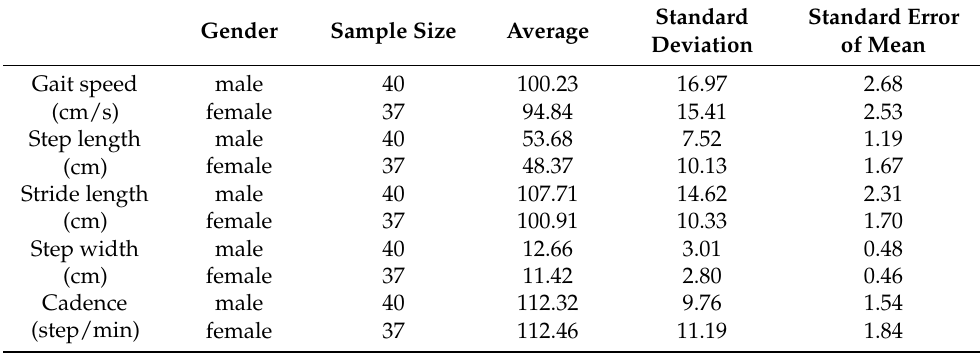
Table 5. Gait factor before standardization.